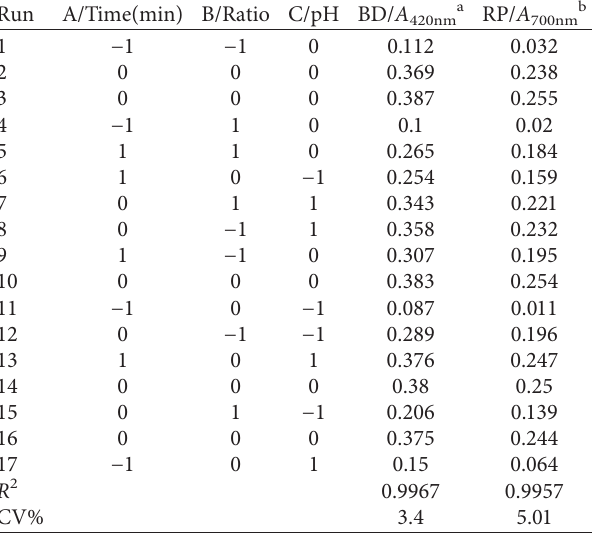
Table 1: Experiment design and results of RSM. Run A/Time(min) B/Ratio C/pH BD/ A 420nma RP/ A